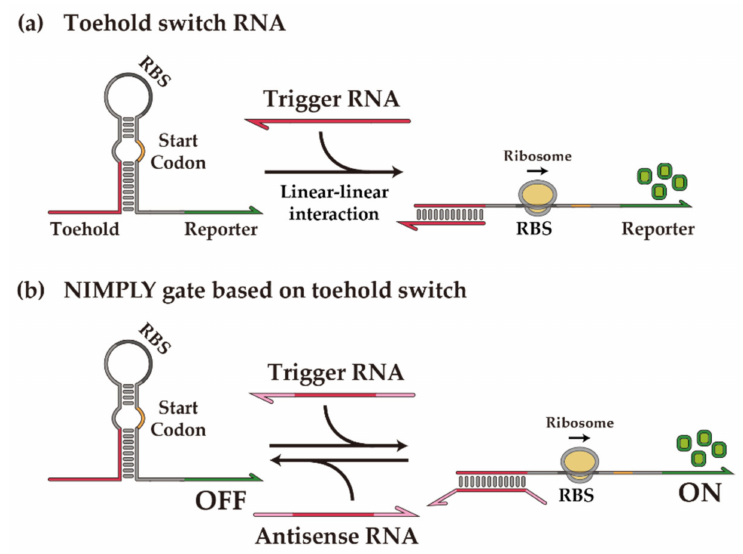
Figure 1. De-novo-designed toehold switch and toehold-switch-based NIMPLY gate. ( a ) Scheme of toehold switch operation. The toehold switch has repressed the translation state through the secondary structure sequestering the RBS and start codon. Linear-linear interaction between the toehold switch and the trigger RNA exposes the RBS and start codon with the strand displacement process; therefore, the translation of the downstream gene is resumed. ( b ) Scheme of NIMPLY gate operation. Antisense RNA has extended overhang sequences at both ends and can inhibit the trigger RNA through sequence displacement or complementary binding. Thus, the toehold switch is reverted to the initial OFF